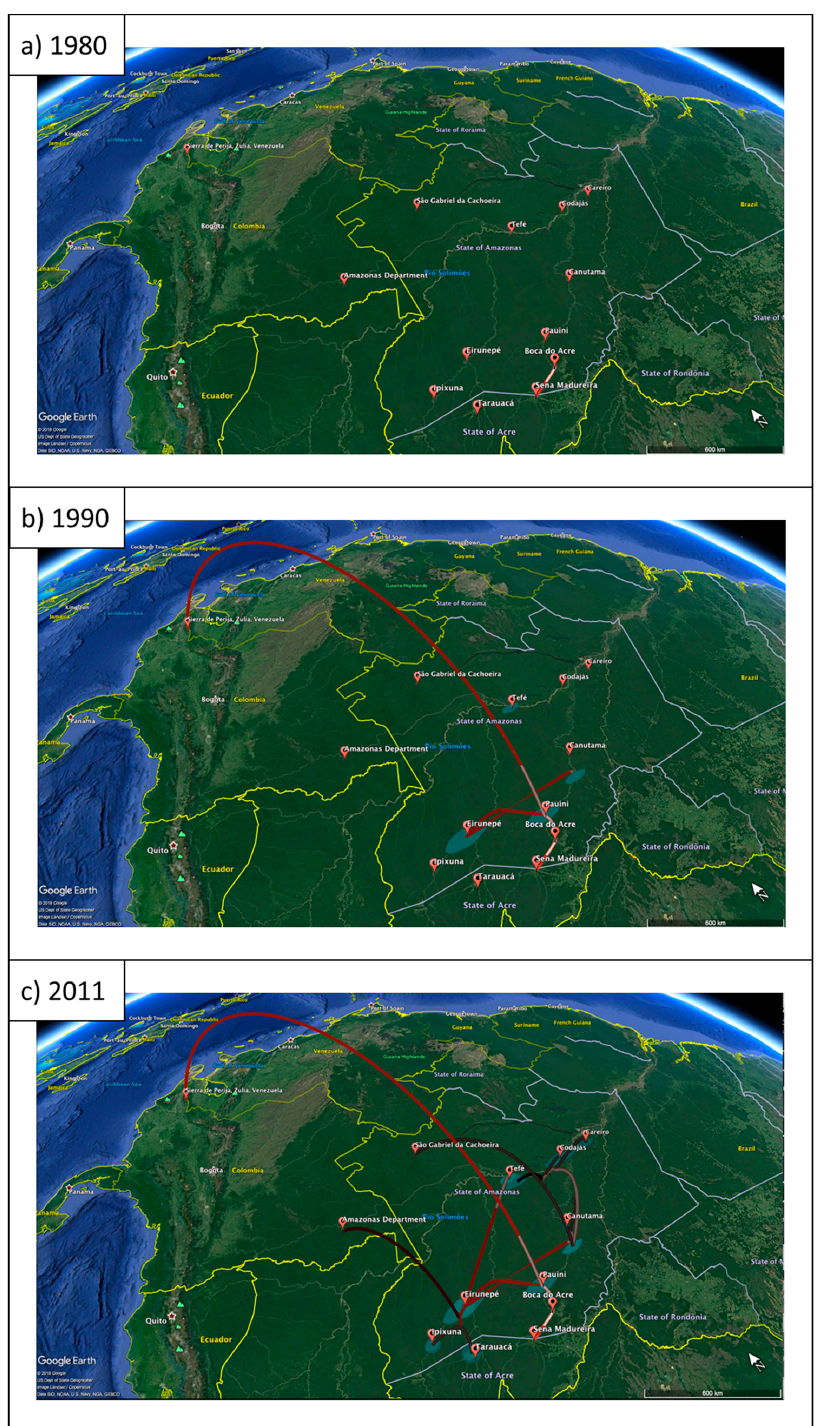
Figure 4. Phylogeographic dispersion of HDV-3 in South America. The spatial phylogenetic reconstruction of the evolutionary dynamics traced in the study is shown in the cartographic plane referring to the region of study. The dispersion lines are indicated according to a time-related color gradient, where red refers to the minimum time and black to the most recent time. Polygons in the plane represent the posterior support of the node, which also accompany a color gradient, ranging from black (lightly supported node) to light blue (well supported